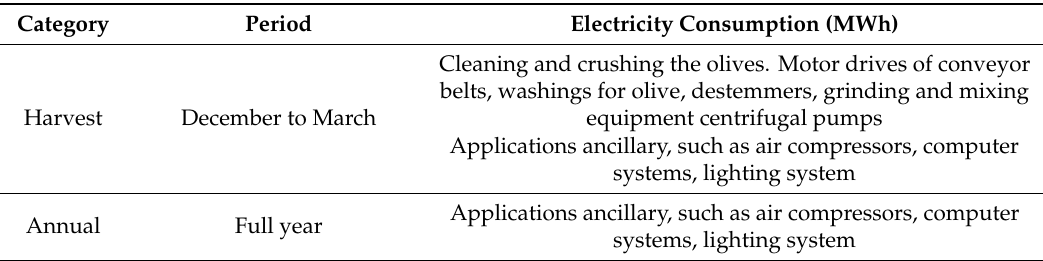
Table 2. Classification according load consumption